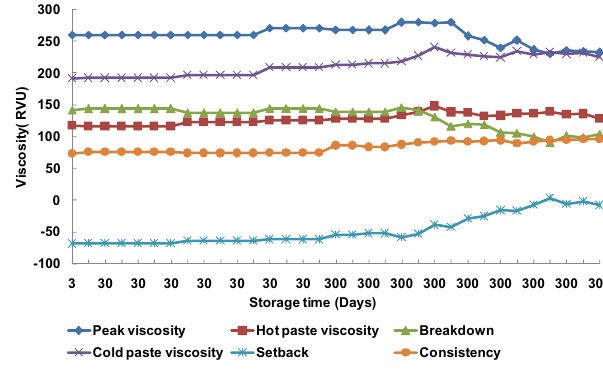
Fig. 2. The change of pasting properties in KDML105 cultivar after